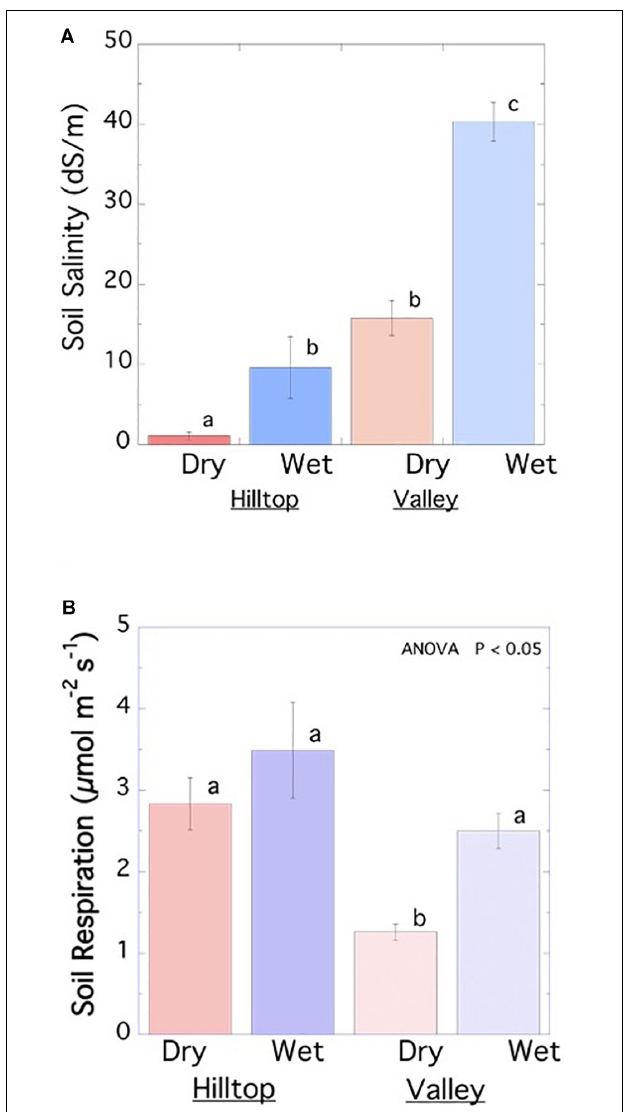
FIGURE 3 | Analysis of soil (A) salinity and (B) respiration in Legacy Park at hilltop low soil salinity and high soil respiration sites compared to valley bottom sites experiencing high salinity and low respiration. Differences between letters on bar graphs indicate significant difference between treatments by one-way ANOVA followed by a Fisher’s least significant difference test at P < 0.05. Error bars on symbols represent ± 1 SE, n =